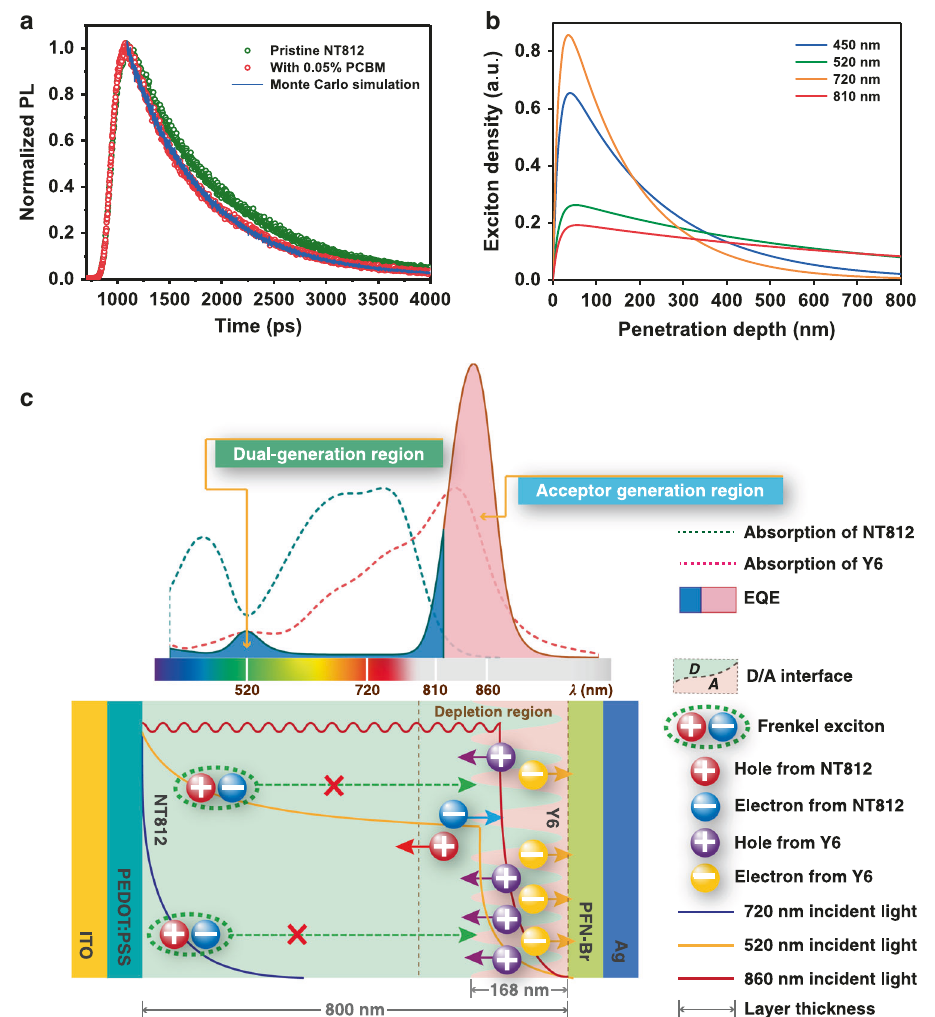
Fig. 2 Working mechanism of SF-narrowband photodetectors. a Experimentally measured time-resolved photoluminescence of pristine (green open circles) and blend fi lm (red open circles). Photoluminescence decay modeled with the Monte Carlo simulation of blend fi lm (blue solid lines). b Exciton density in the bulk of NT812 versus penetration depth of incident light with different wavelength from the transparent ITO electrode. c Diagrammatic illustration of the working mechanism of self- fi ltering (SF) narrowband